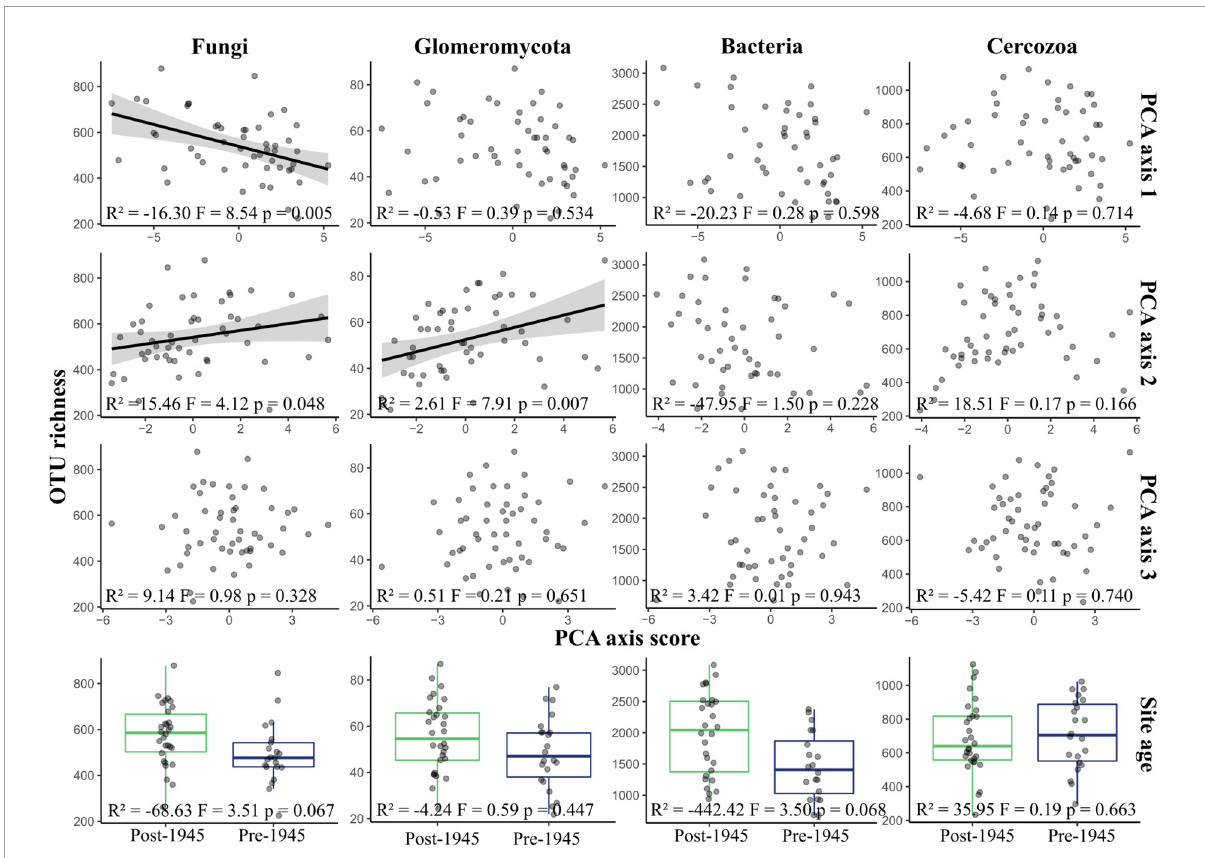
FIGURE2 Variation of OTU richness in taxonomic groups across environmental gradients. The figure displays a graphical representation of the results of multiple linear regressions of OTU richness within each taxonomic group. The regression model was Site age + PCA axis 1 + PCA axis 2 + PCA axis 3. Each plot shows richness plotted against site scores for the three PCA axes, representing environmental syndromes, and site age. Please note that lower scores for PCA axis 1 represent more urban sites. Lines are plotted on correlations for which p ≤ 0.05; these are linear model regression lines, with gray areas representing 95% confidence areas. Boxplots show the mean, 25th, and 75th percentiles, with whiskers extending to the range, excluding outliers. Statistical results are reported at the bottom of each